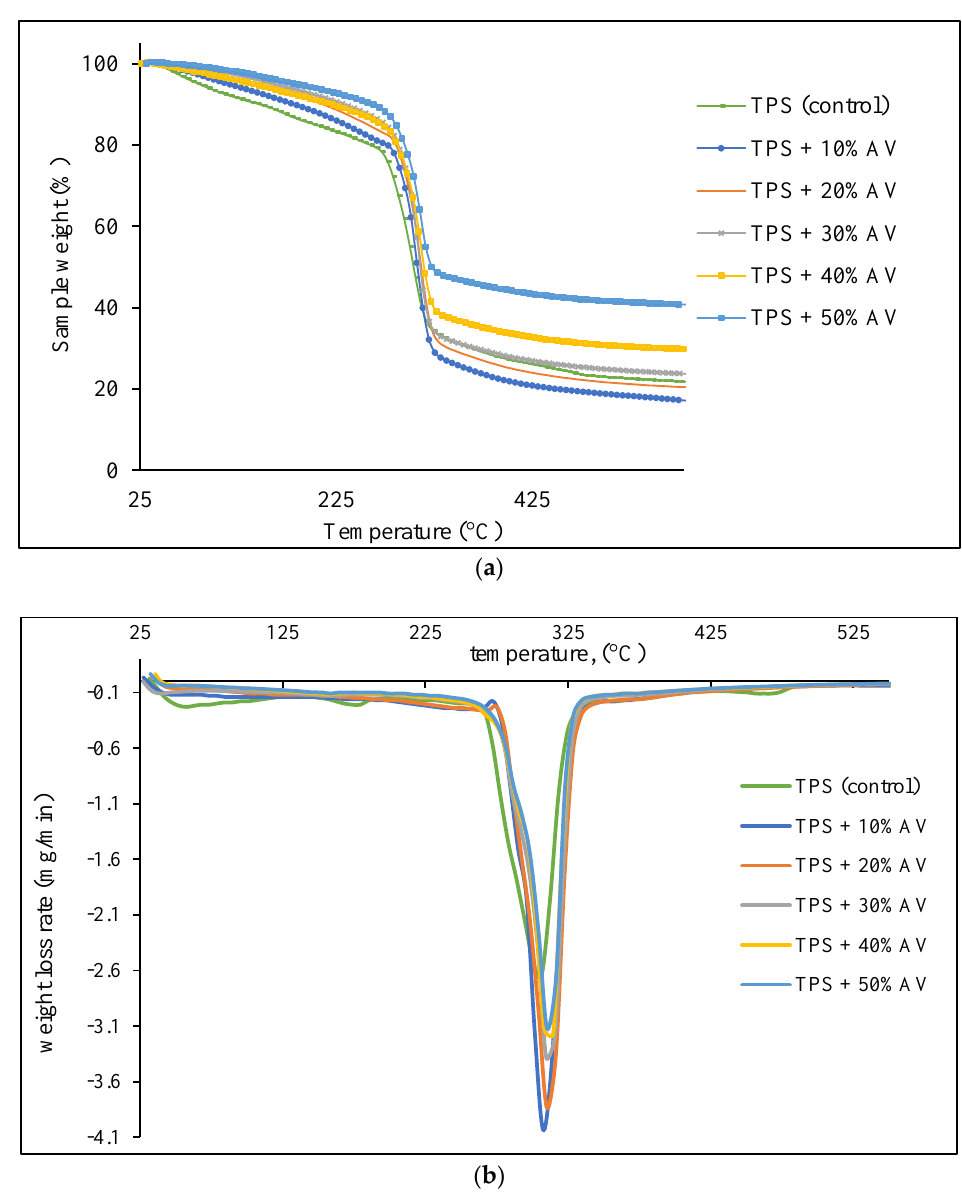
Figure 3. ( a ) The thermogravimetric and ( b ) the derivative thermogravimetric (DTG) analyses of TPS film with different AV gel concentrations.